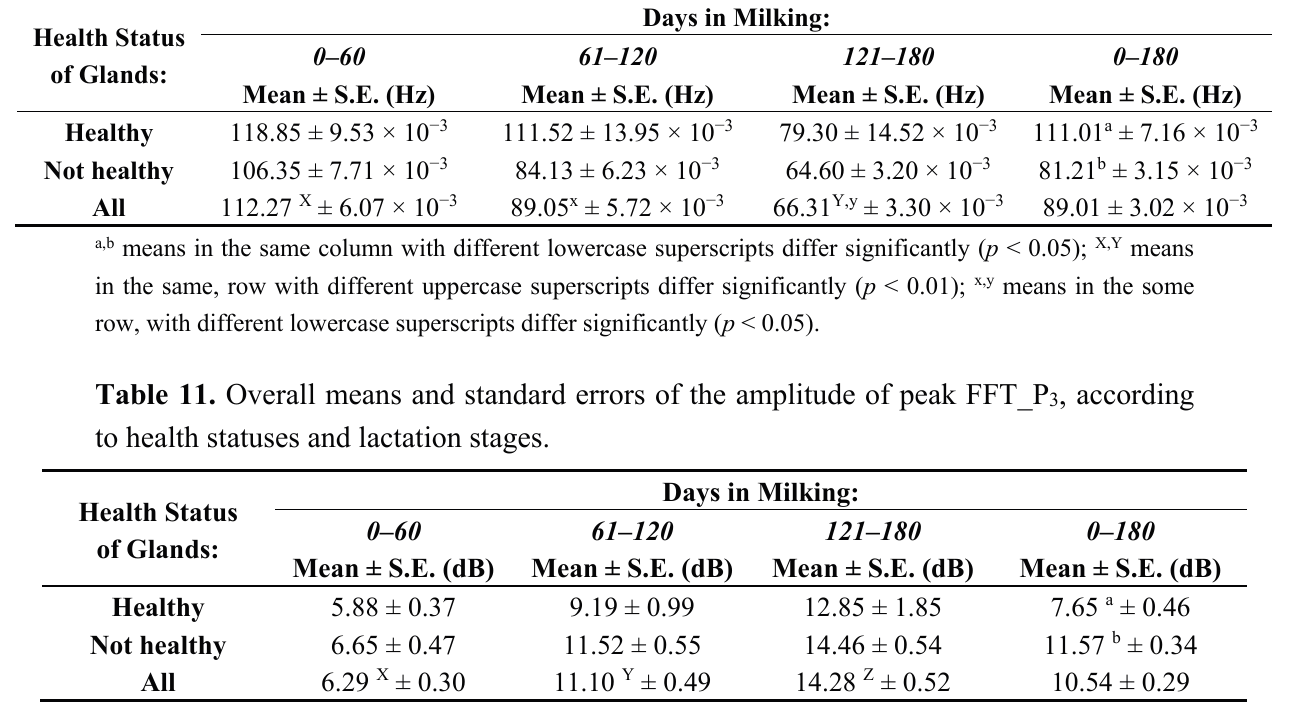
Table 10. Overall means and standard errors of the frequency of peak FFT_P 3 , according to health statuses and lactation stages.